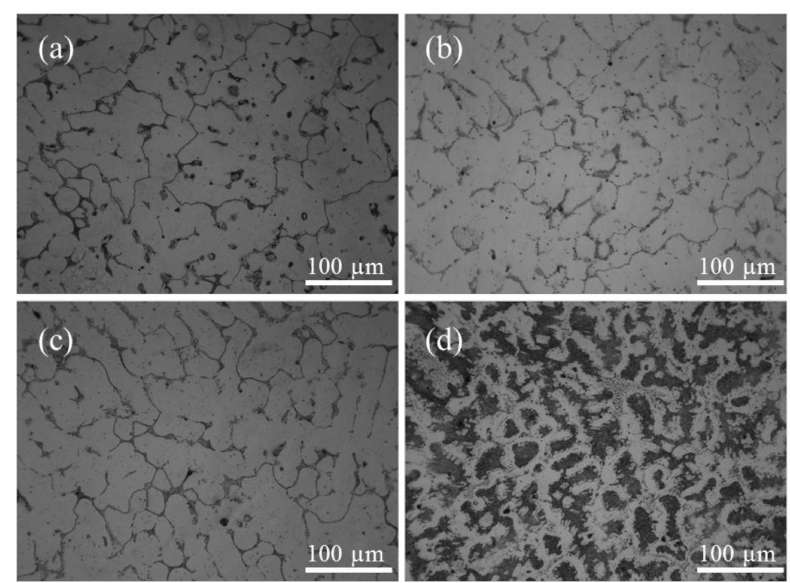
Figure 1. Microstructures of the steels with ( a ) 0, ( b ) 1.76, ( c ) 3.45, and ( d ) 5.34 wt% Al.